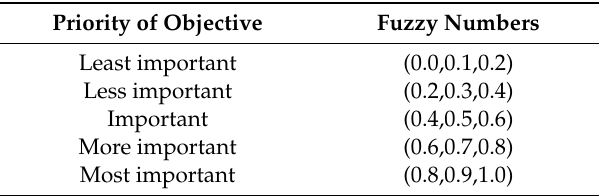
Table 2. Fuzzy numbers scale for the importance of